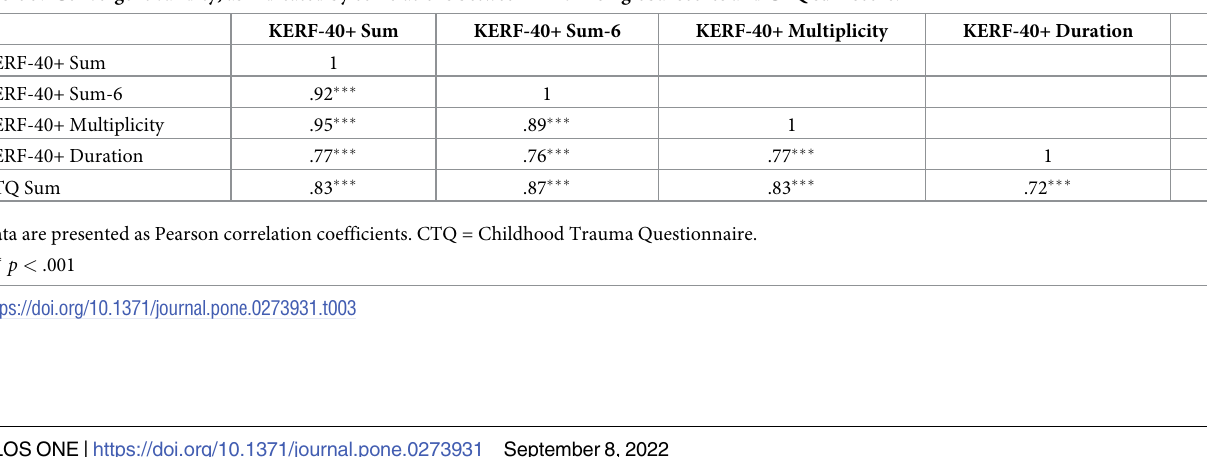
Table 3. Convergent validity, as indicated by correlations between KERF-40+ global scores and CTQ sum